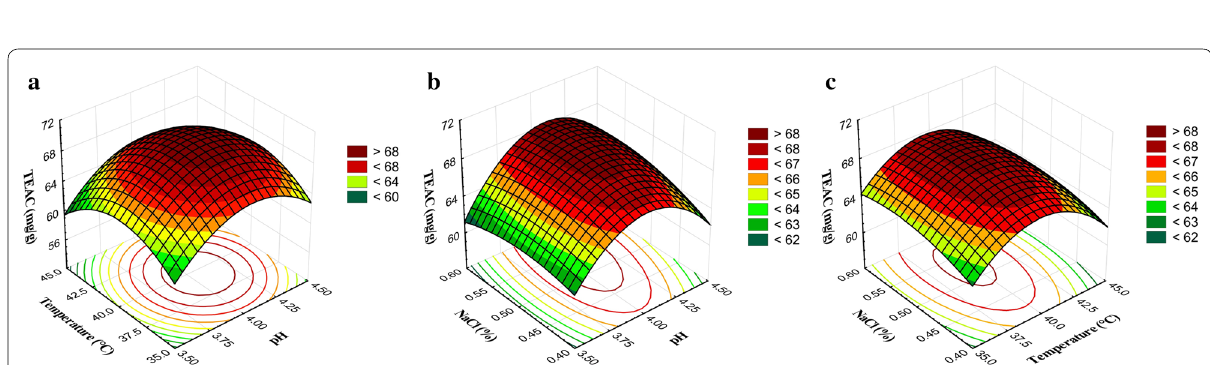
Fig. 2 Response surface plot for the antioxidant capacity of FRB describing the interaction of independent variables namely, pH, temperature, and NaCl concentration on antioxidant capacity of FRB. The values were represented as trolox equivalent of antioxidant capacity (TEAC). a Effect of temperature and pH on antioxidant capacity of FRB, b effect of NaCl concentration (%) and pH on antioxidant capacity of FRB, and c effect of NaCl concentration (%) and temperature on antioxidant capacity of